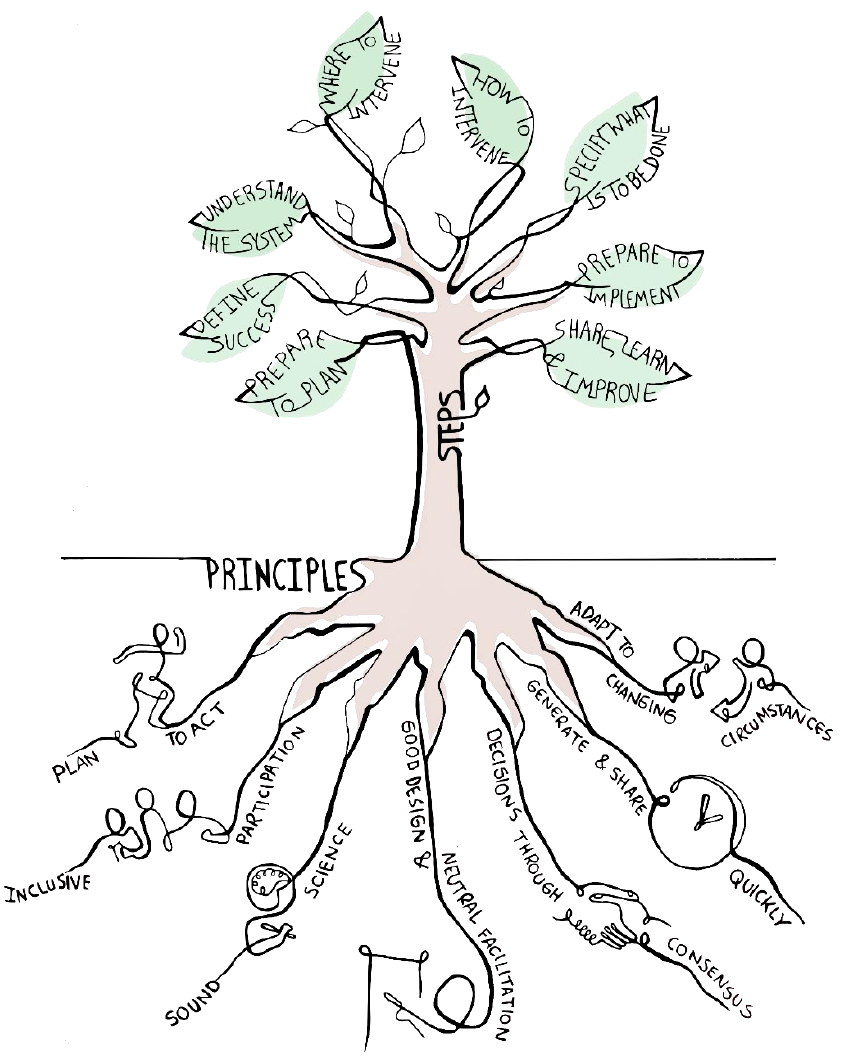
Figure 1. The SSC CPSG approach to species conservation planning: Core principles are represented as stable roots, while the leaves represent the planning steps that continue to evolve in response to the increasing complexity of today’s wildlife conservation challenges. Design and artwork: Eugenia Cordero Schmidt.